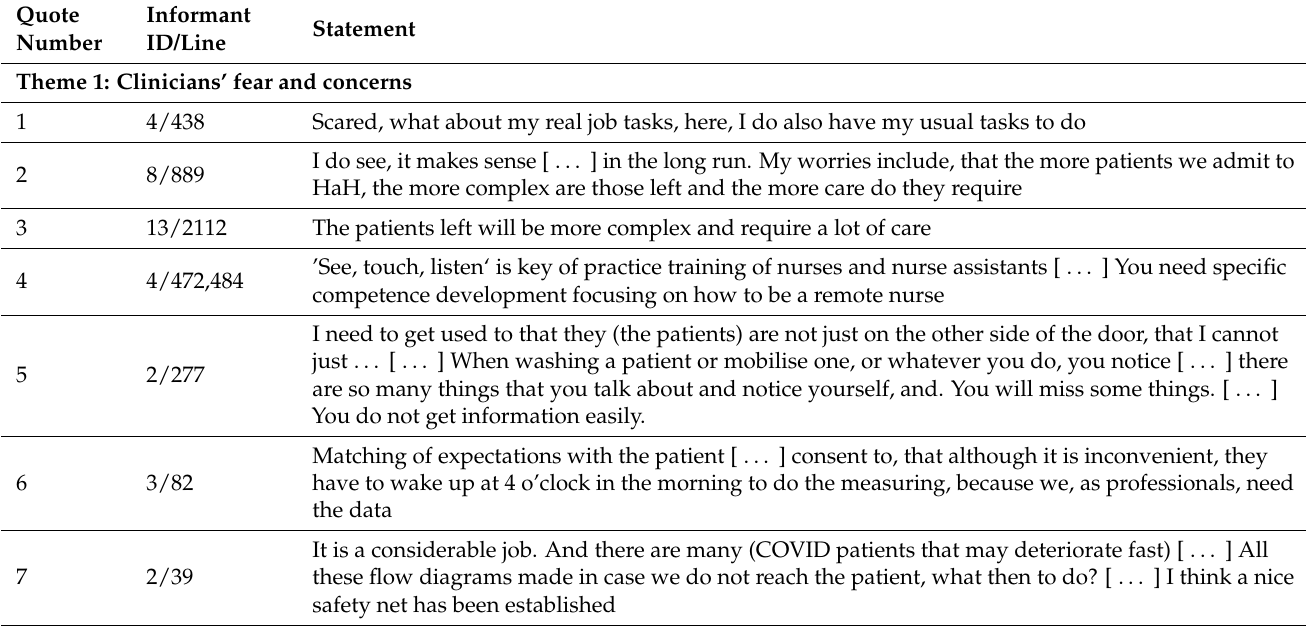
Table 1. Quotes from the clinicians’